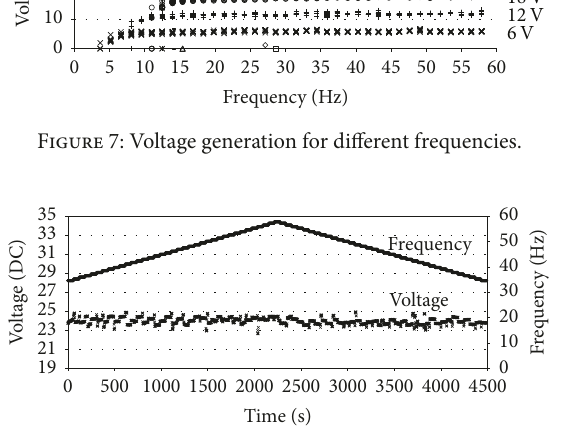
Figure 8: Voltage control for a constant ratio of frequency change.